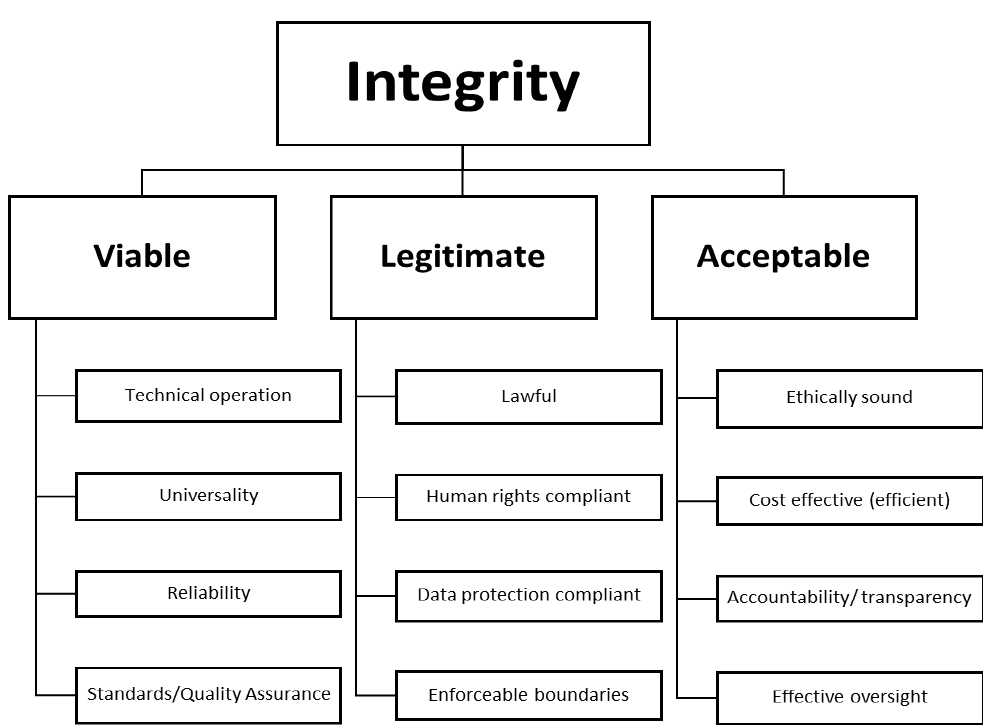
Figure 1. The ‘Integrity Matrix’.